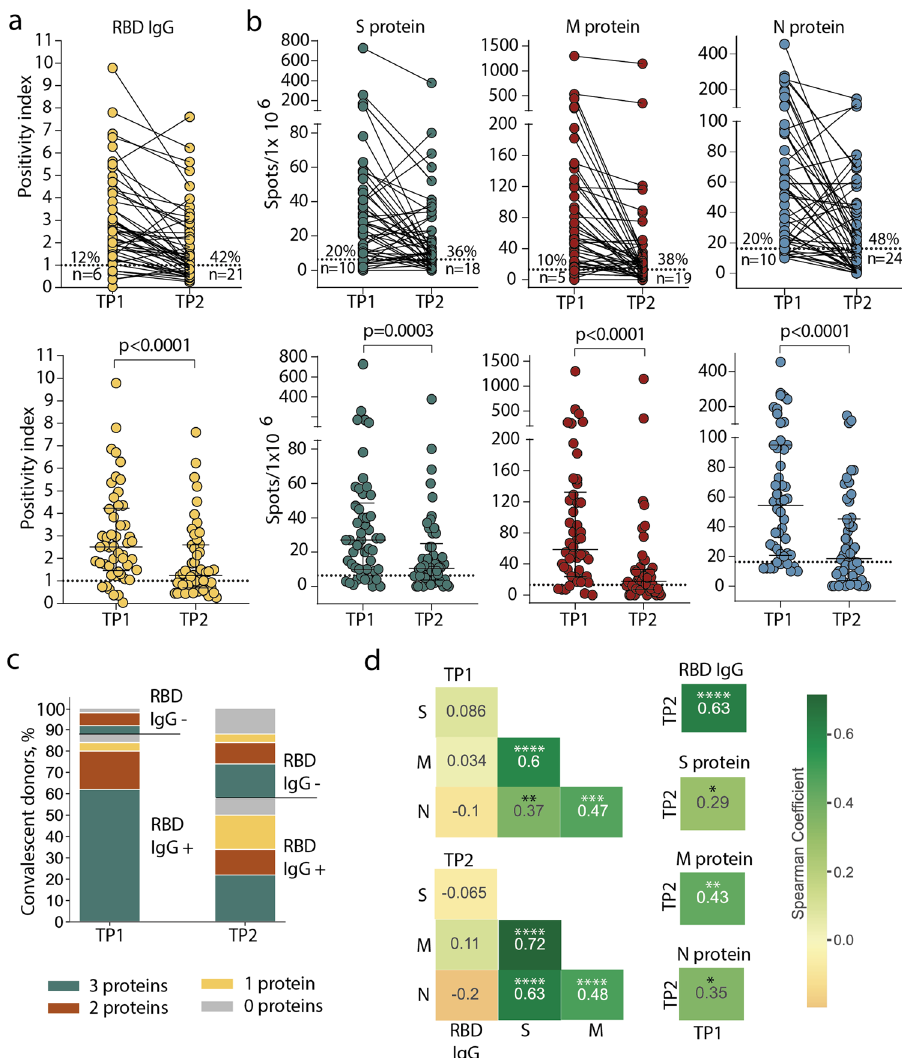
Fig. 1 Persistence of humoral and cellular response in CP cohort. a Levels of anti-RBD IgG as measured by ELISA at the two time-points. Means of two independent measurements are plotted. Upper plot shows samples from the same donor, connected by lines. Lower plot shows median, whiskers show interquartile range (paired Wilcoxon test); b magnitude of T-cell response to pools of peptides derived from S (green), M (red), and N proteins (blue) as measured by IFN γ ELISpot. Means of two independent measurements with negative control subtracted are plotted. Plots are presented as in a . Dotted lines in a and b mark cut-offs, the number and share of individuals without detectable response is indicated. N = 50 for both a and b ; c distribution of immune responses in CPs. Colors indicate T-cell response to 0 – 3 peptide pools; RBD IgG + and RBD IgG- respectively indicate the presence and absence of anti- RBD IgG; d Spearman correlation between humoral and cellular responses to different SARS-CoV-2 antigens. * p ≤ 0.05; ** p ≤ 0.01; *** p ≤ 0.001; **** p ≤